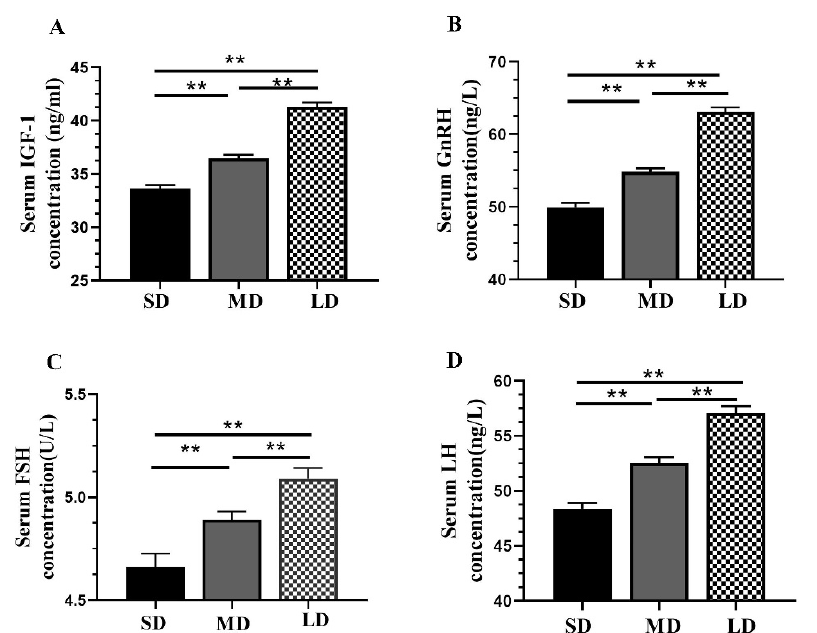
Figure 2. Differential analysis of the serum hormone concentrations in Phodopus sungorus under different photoperiod conditions. ( A ) IGF-1; ( B ) GnRH; ( C ) FSH; and ( D ) LH. Values are the means ± SEM. n = 11. SD, short daylight; MD, moderate daylight; LD, long daylight. ** p < 0.01.